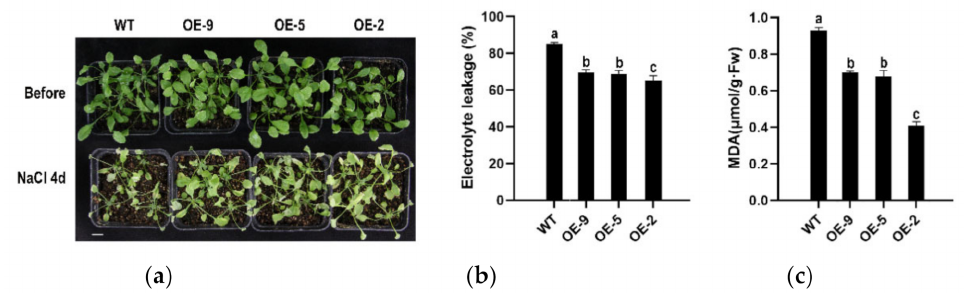
Figure 6. Heterologous expression of CpBBX19 enhanced salt tolerance of transgenic Arabidopsis plants. ( a ) Performance of Arabidopsis overexpressing CpBBX19 (OE lines) under NaCl treatment. Bar denotes 1 cm. ( b ) Electrolyte leakage of WT and OE lines under NaCl treatment. ( c ) MDA content of WT and OE lines under NaCl treatment. Data represent the mean of three biological repeats ± SD. Error bars indicate standard deviation. Different lowercase letters (a, b, c) on bars indicate significant differences ( p < 0.05).